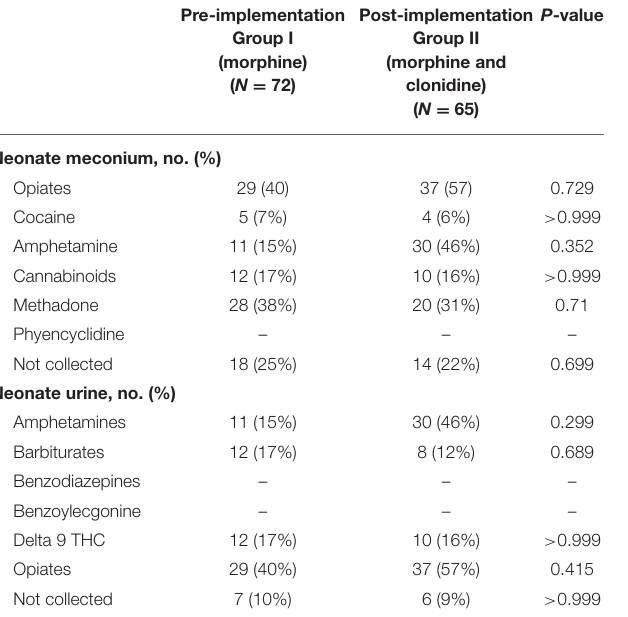
TABLE 4 | Neonatal outcomes pre and post implementation of NAS treatment algorithm.